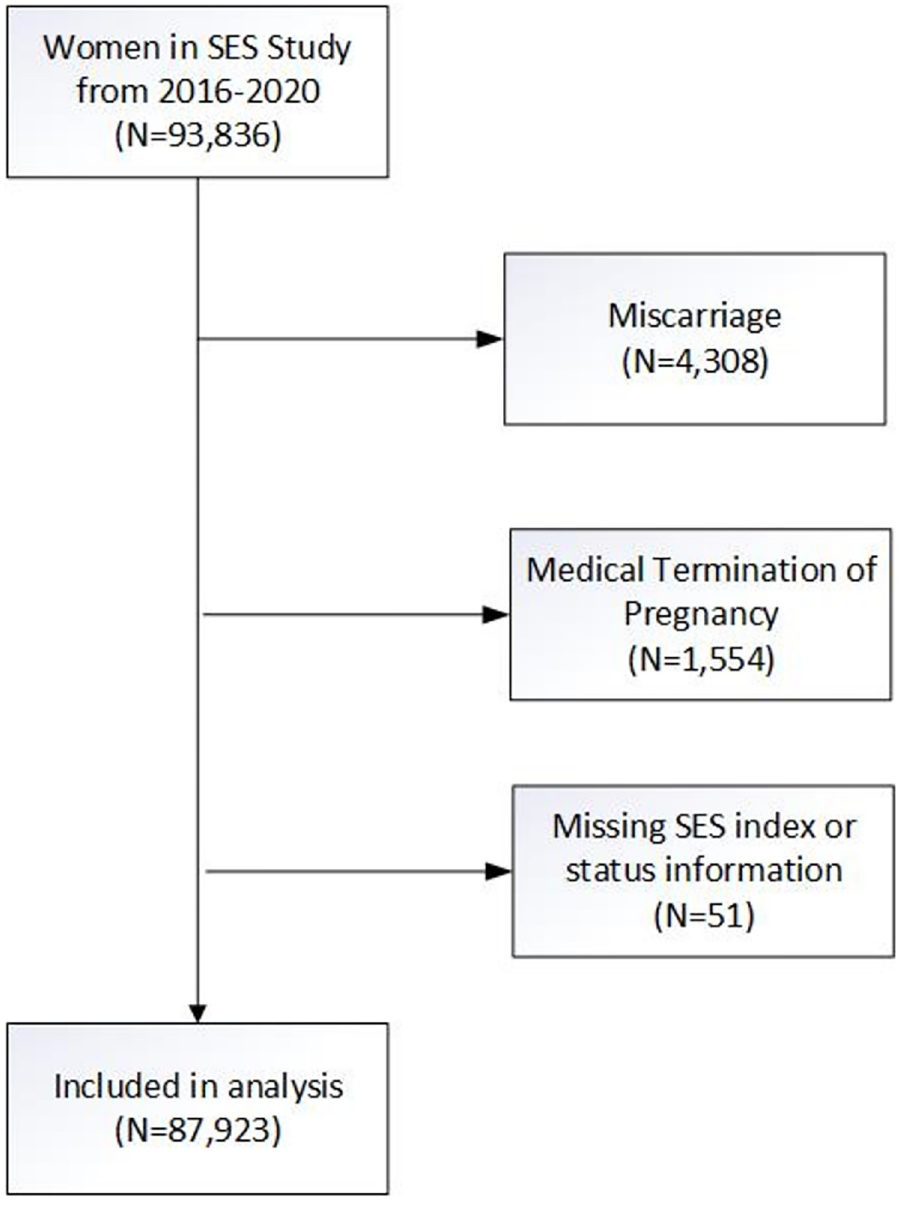
Fig 1. CONSORT diagram of participant